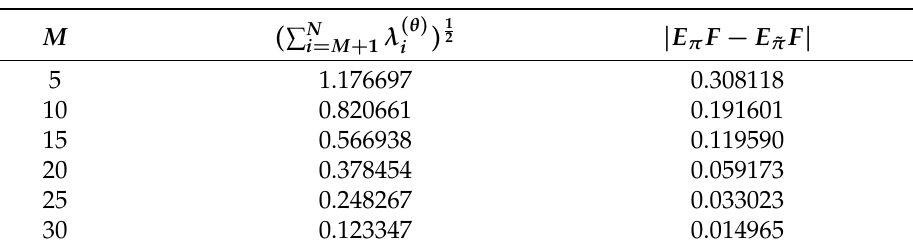
E π F E ˜ π F when the K-L expansion is truncated to M terms. Here l 1 = 0.2, | − | = 0.005. f